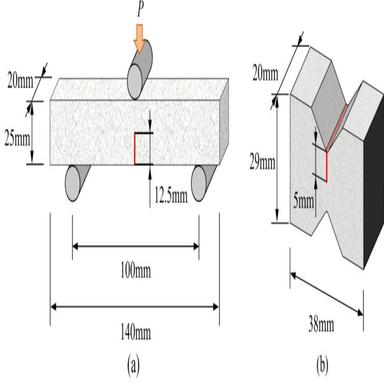
Schematic of specimens for mode I, mode II and mixed-mode fracture toughness. (a) Single edge notch beam (SENB) specimen for mode I fracture toughness; (b) Cracked butterfly-shape specimen for mode II and mixed-mode fracture toughness.